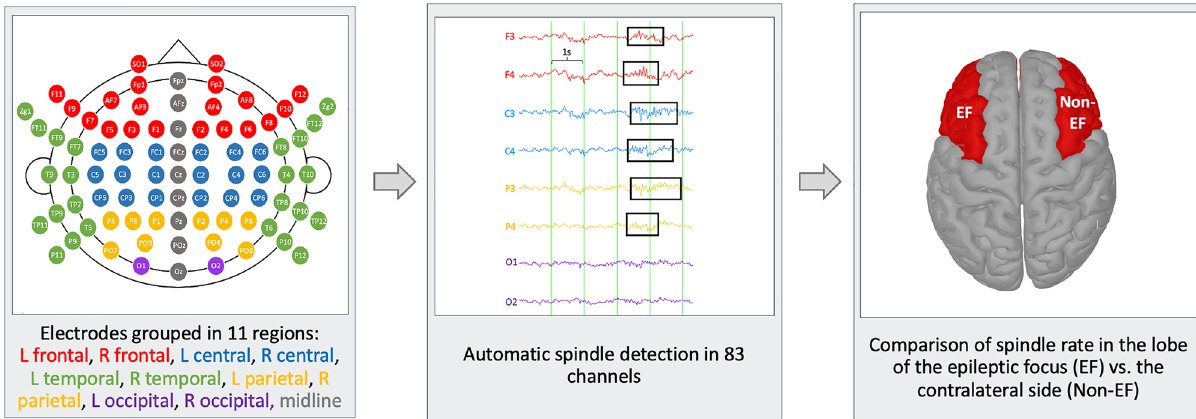
Figure 1. Workflow of the study procedures.